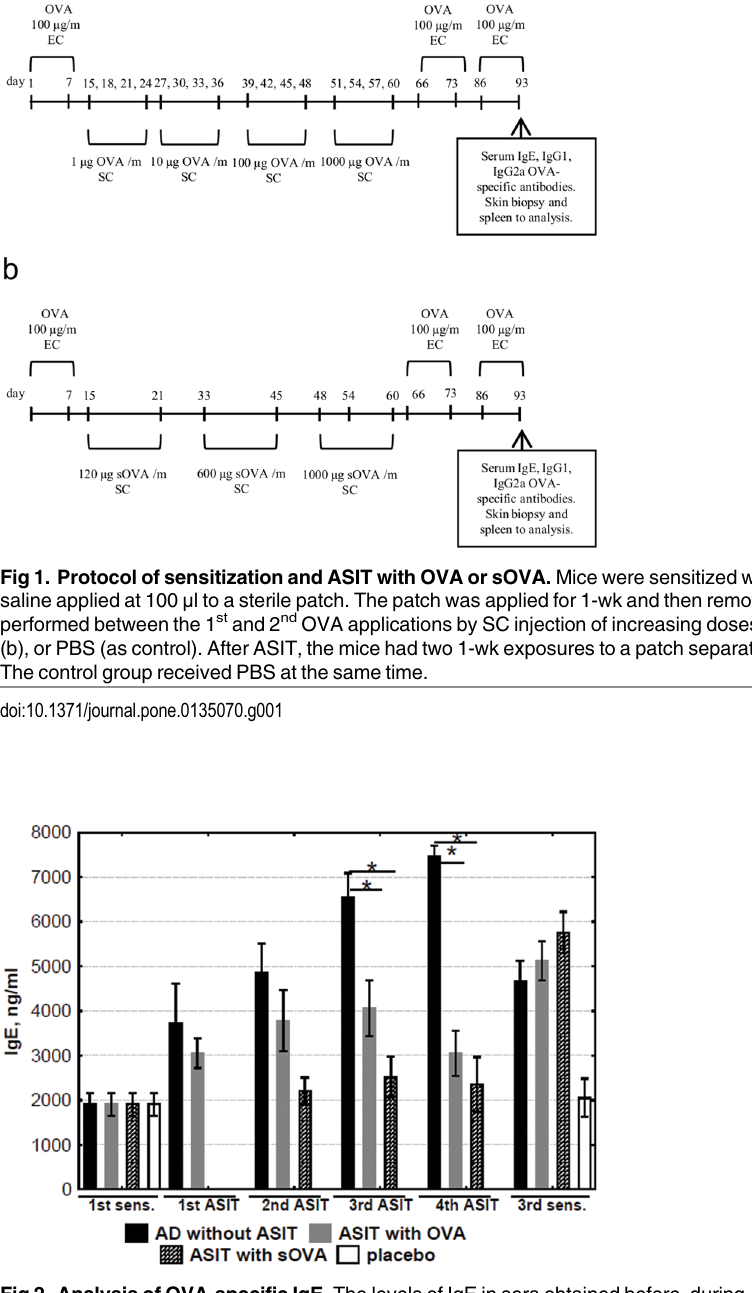
Fig 2. Analysis of OVA-specific IgE. The levels of IgE in sera obtained before, during, and after ASIT were detected and quantified by ELISA. The results are presented as mean IgE concentration (mean ± SE, n = 8 for each). AD without ASIT: OVA-sensitized untreated mice; ASIT with OVA: OVA-sensitized mice treated by ASIT with OVA; ASIT with sOVA: OVA-sensitized mice treated by ASIT with sOVA; placebo: PBS-sensitized mice. ( * , p <